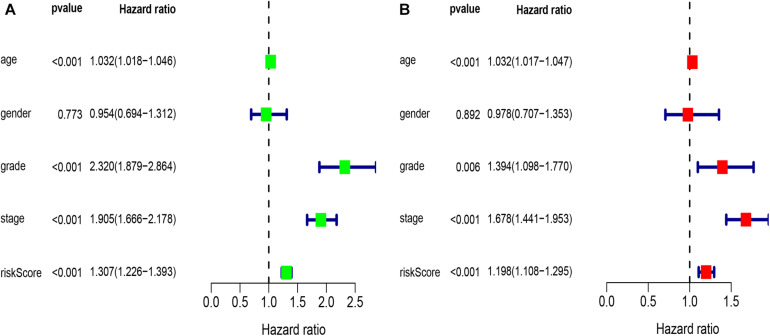
Results of the univariate and multivariate Cox regression analyses regarding OS in the TCGA derivation cohort. (A) Results of the univariate Cox regression analyses. (B) Results of the multivariate Cox regression analyses.